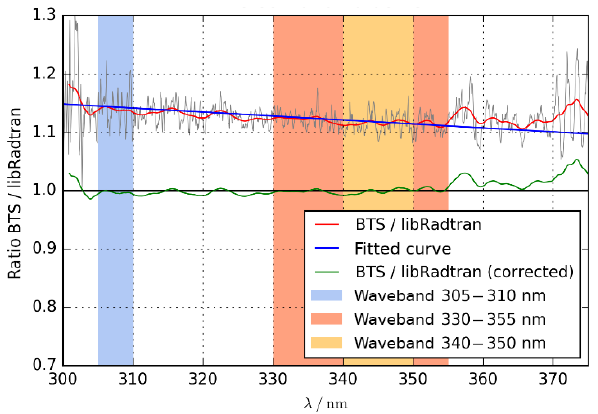
Figure 7. Example of the atmospheric correction applied to a TOC calculation of BTS data on 20 September 2016, 10:06UTC. The waveband ranging from 330 to 355nm was used to derive the slope of the blue fitting line. The green line is the ratio of a BTS measure- ment and a libRadtran calculation after subtracting the blue fitting line.